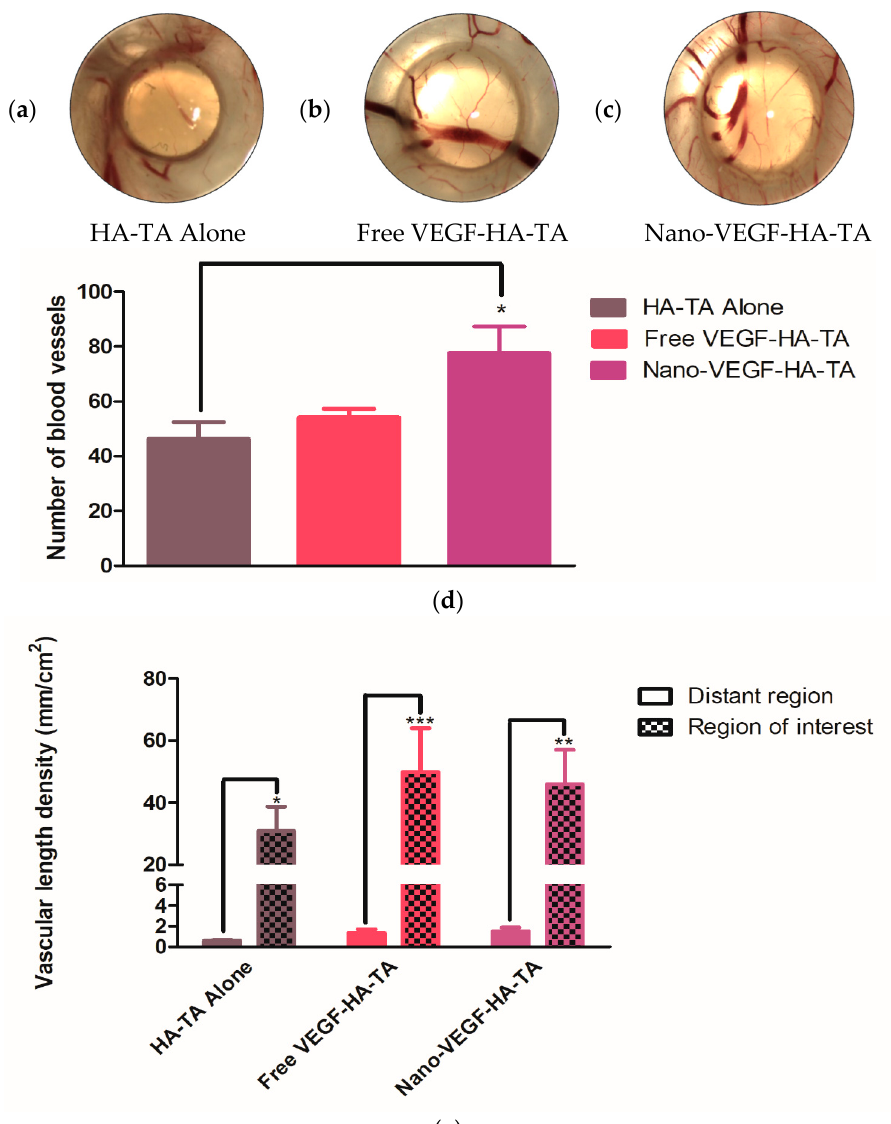
Figure 5. Regions of interest around ( a ) HA-TA alone, ( b ) free VEGF-HA-TA and ( c ) nano-VEGF- HA-TA, representative of those used to calculate vessel number, length density and branch points. One representative image is shown from n = 5 in each group. ( d ) Quantification of the number of vessels in the region of interest around HA-TA alone, free VEGF-HA-TA (500 ng VEGF) and nano- VEGF-HA-TA (500 ng VEGF). ( e ) Vascular length density in the region of interest surrounding the hydrogels compared to the vascular length density of a distant area of the chorioallantoic membrane. * p < 0.05, ** p < 0.01, *** p < 0.001. ( n = 5).